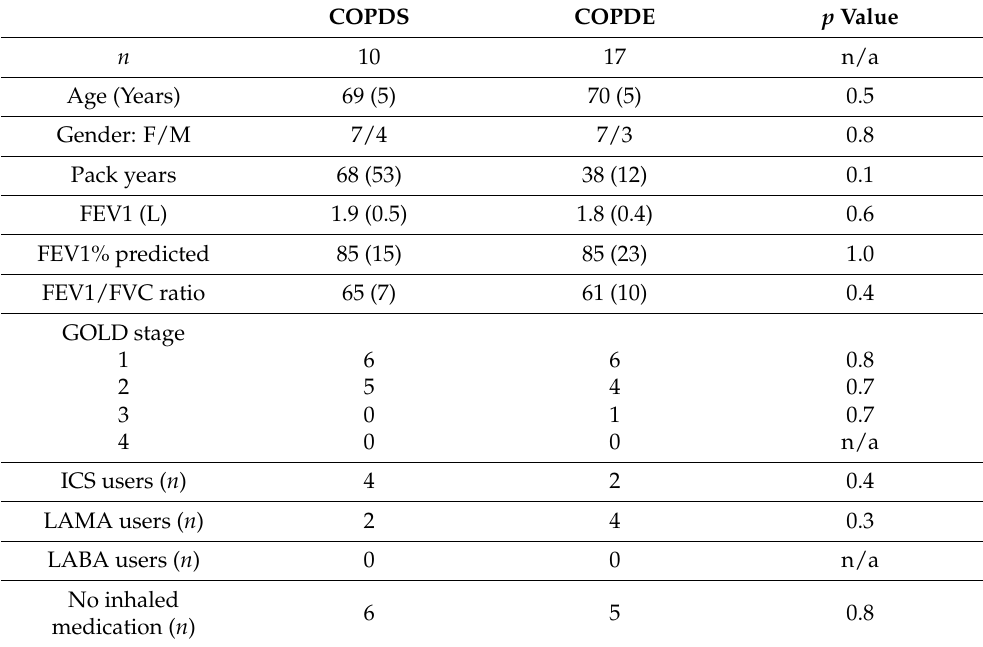
Table 2. Clinical characteristics of the lung macrophage study